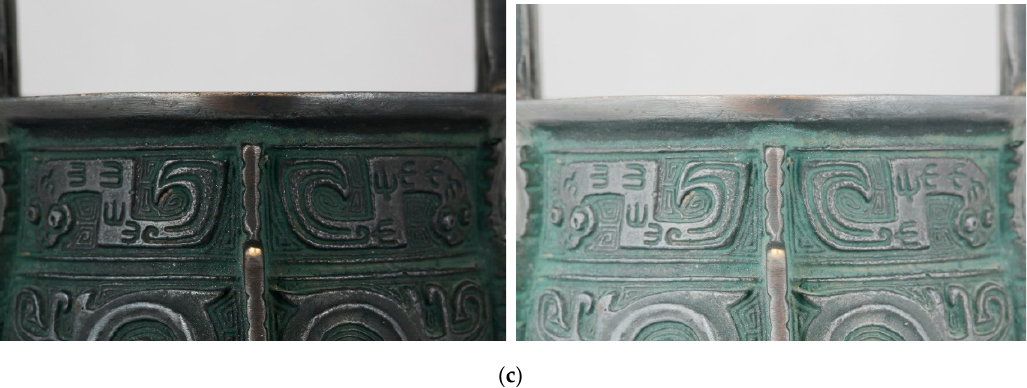
Figure 7. Image samples. ( a ) Highly fuzzy; ( b ) general light supplement; ( c ) general light subtraction.